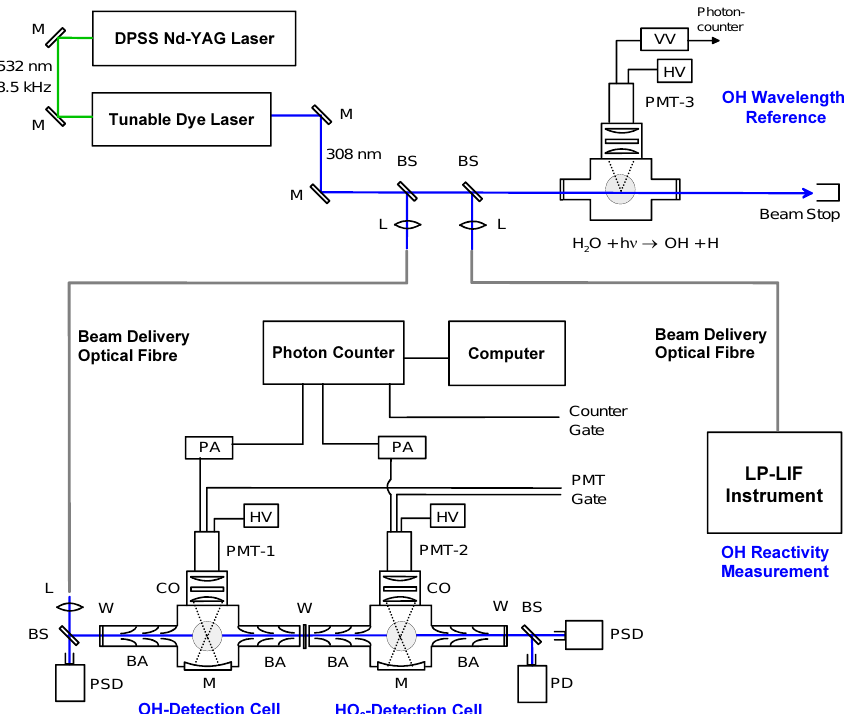
Fig. 2. Schematic drawing of the LIF system. Laser radiation (308nm) from a tunable dye laser is distributed by beam steering optics (M, BS, L) and optical fibres to (a) a pair of independent detection chambers for measurement of OH and HO 2 concentrations, (b) a laser photolysis laser-induced fluorescence (LP-LIF) instrument for measurement of k OH , and (c) a wavelength reference cell in which photolytically gener- ated OH is monitored by LIF. Note that the sampled ambient air is flowing through the low-pressure detection chambers perpendicular to the optical plane shown in the figure. Abbrev.: M mirror, BS beam splitter, L lens, W quartz window, CO fluorescence collection optics, BA laser baffle arm, PD photodiode, PSD position-sensitive photodiode, PMT photomultiplier tube, HV high voltage supply, PA